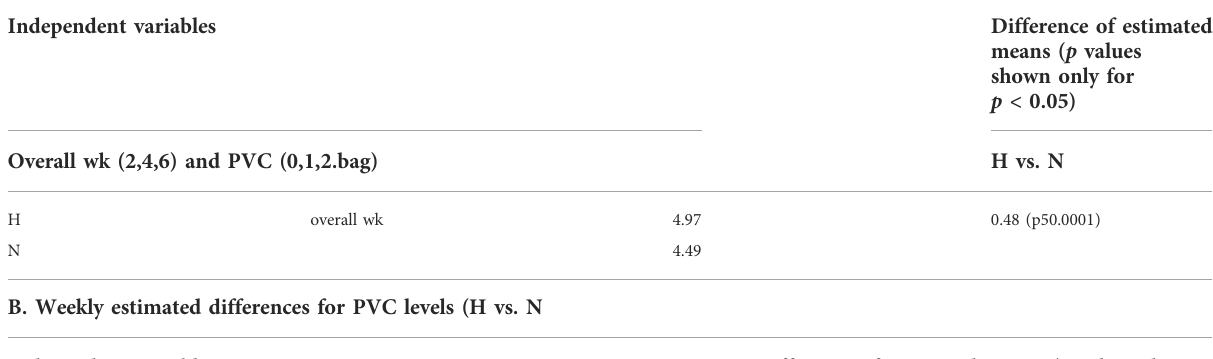
TABLE 3 ATP: Mean estimated values from the model. A. Overall estimated differences for storage condition (H vs. N) Independent variables Difference of estimated